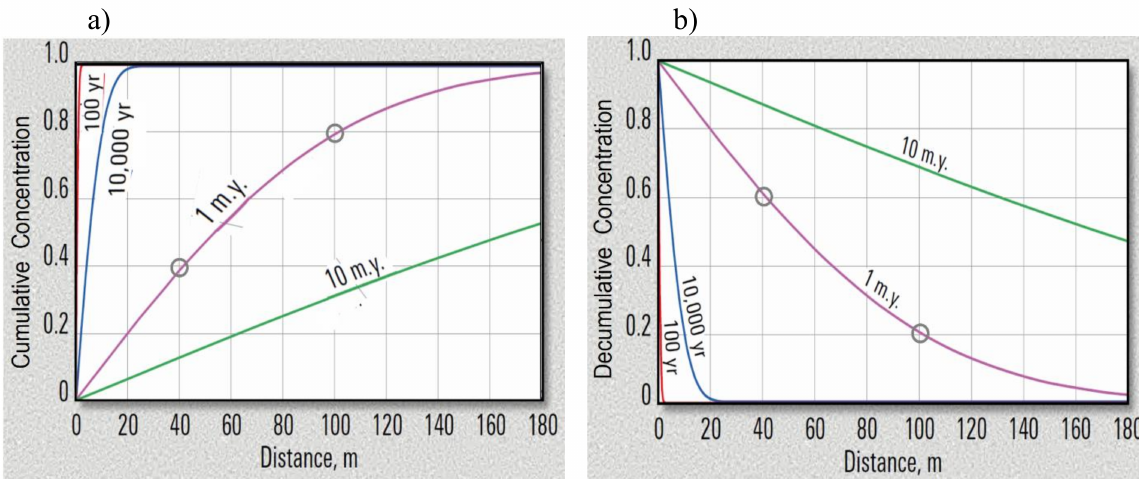
Figure 5. ( a ) Ascending cumulative probability function; ( b ) descending cumulative probability function. Diffusion times shown are for 100 years, 10,000 years, 1 million years and 10 million years. The value of the diffusion constant for these curves was D m = 10 − 6 cm 2 /s. Circles are reference points used for graph interpretation in the main text. Adapted and re-interpreted from Mullins